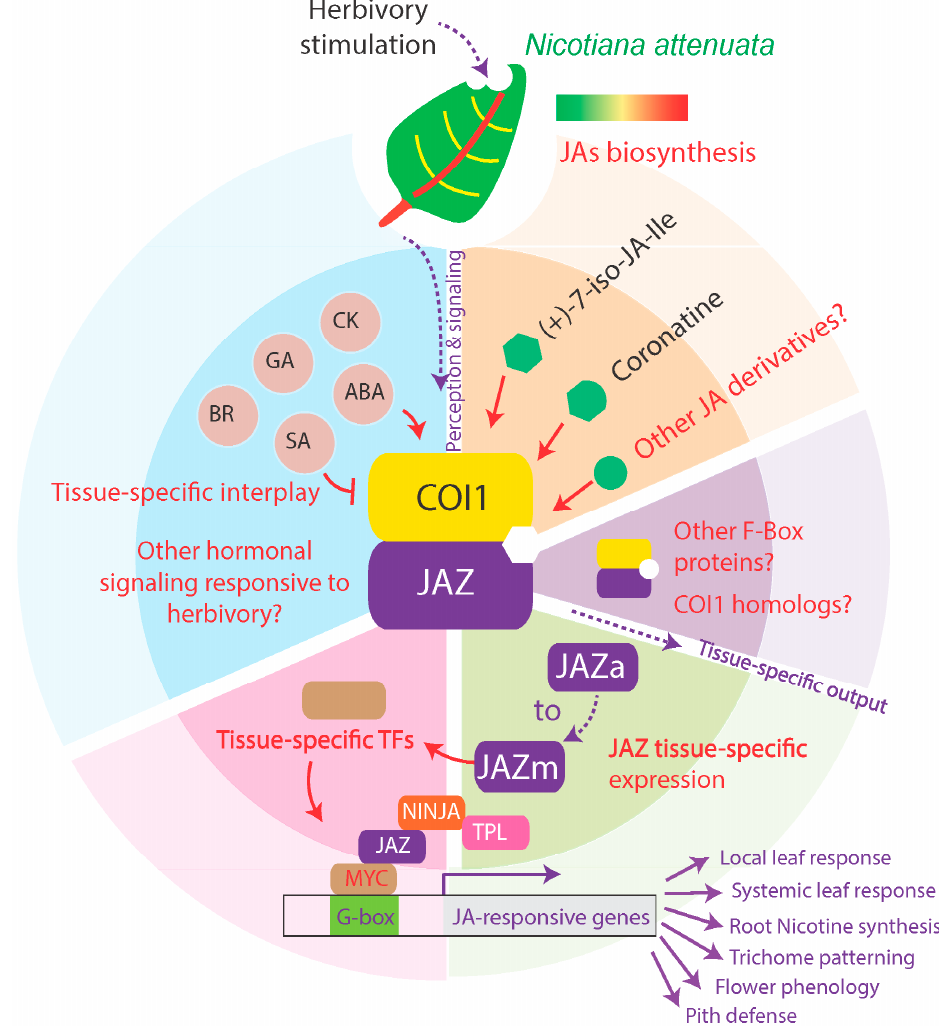
Figure 1. Schematic model of modulations in jasmonate perception, signaling and corresponding tissue-specific herbivory-elicited responses. New discoveries in jasmonate signaling in the ecological model, Nicotiana attenuata are presented. The small circle at the top represents jasmonate biosynthesis after herbivore attack; the inner circle represents jasmonate perception and signaling, the outer larger circle represents outputs of tissue-specific responses. The six different types of modulations from the canonical model of jasmonate signaling are presented in different colors. White, jasmonate biosynthesis deviates in different tissue types of leaves; orange, other jasmonate derivatives that are likely to serve as ligands need to be discovered; purple, other F-box proteins may serve as functional groups; green, tissue-specific JAZ expressions need to be fully investigated; pink, tissue-specific transcription factors are yet to be discovered; blue, deviations of hormonal crosstalk in different tissues. Red texts indicate areas where modulations are likely to take place. TPL, TOPLESS.